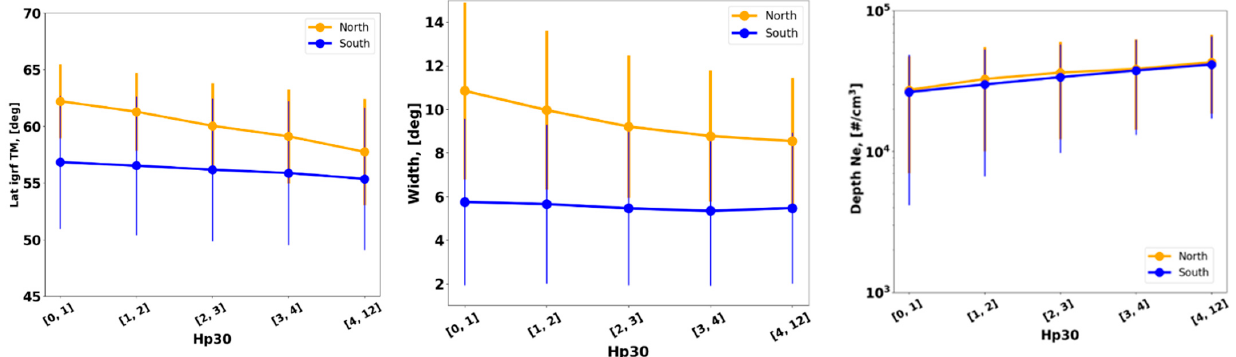
Figure 19. Hp30 index dependence of the trough minimum position, trough width, and trough depth for the northern and southern